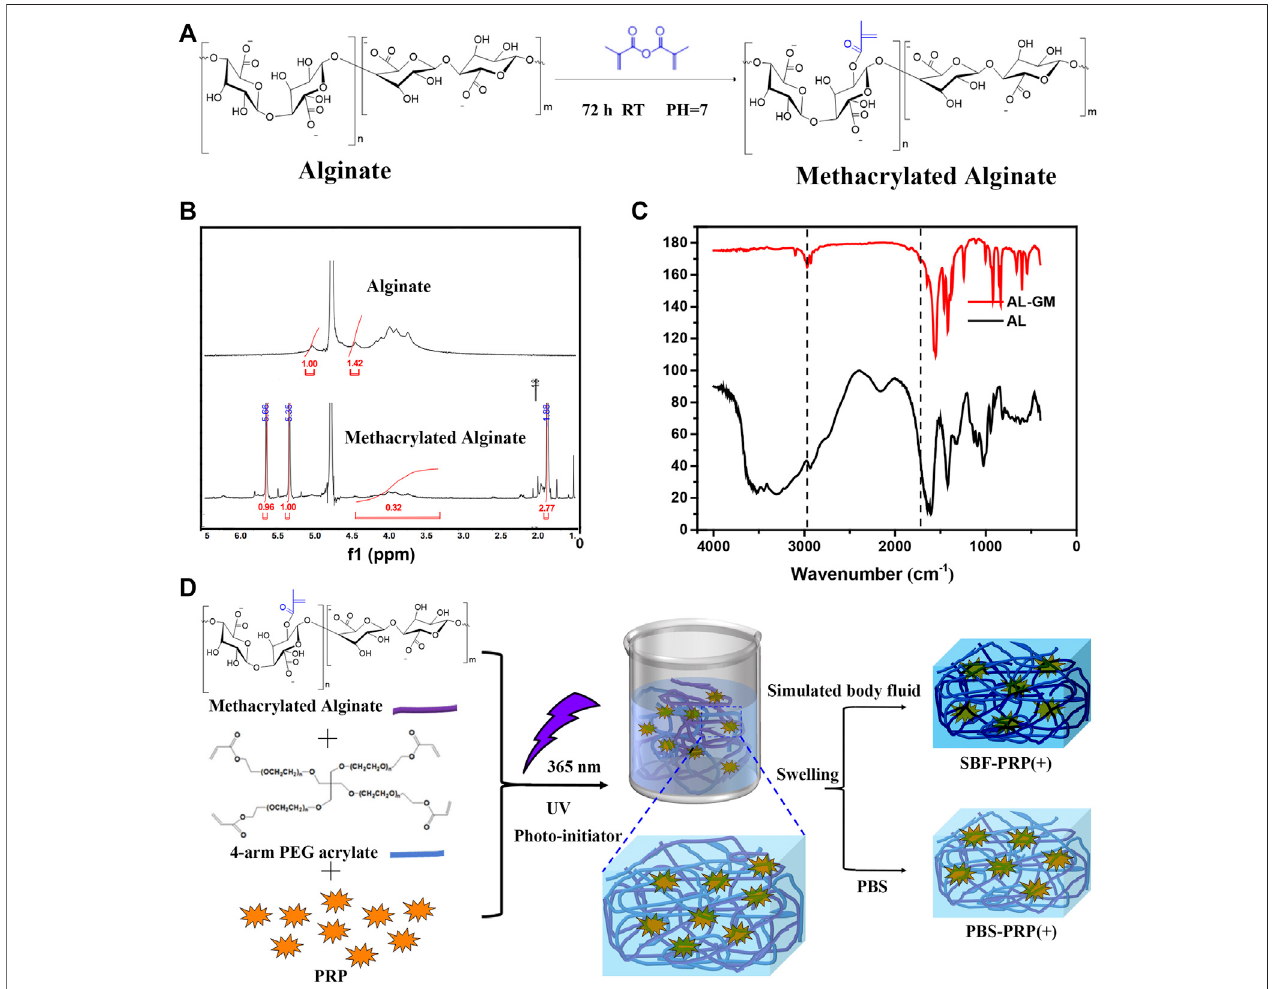
FIGURE1| PreparationofIPN M-ALG/PEGhydrogels. (A) Reactionschemes, (B) 1H-NMRspectraand (C) FTIRspectraofM-ALG. (D) Schematicofpreparation process of IPN M-ALG/PEG hydrogels alone or combine with PRP.